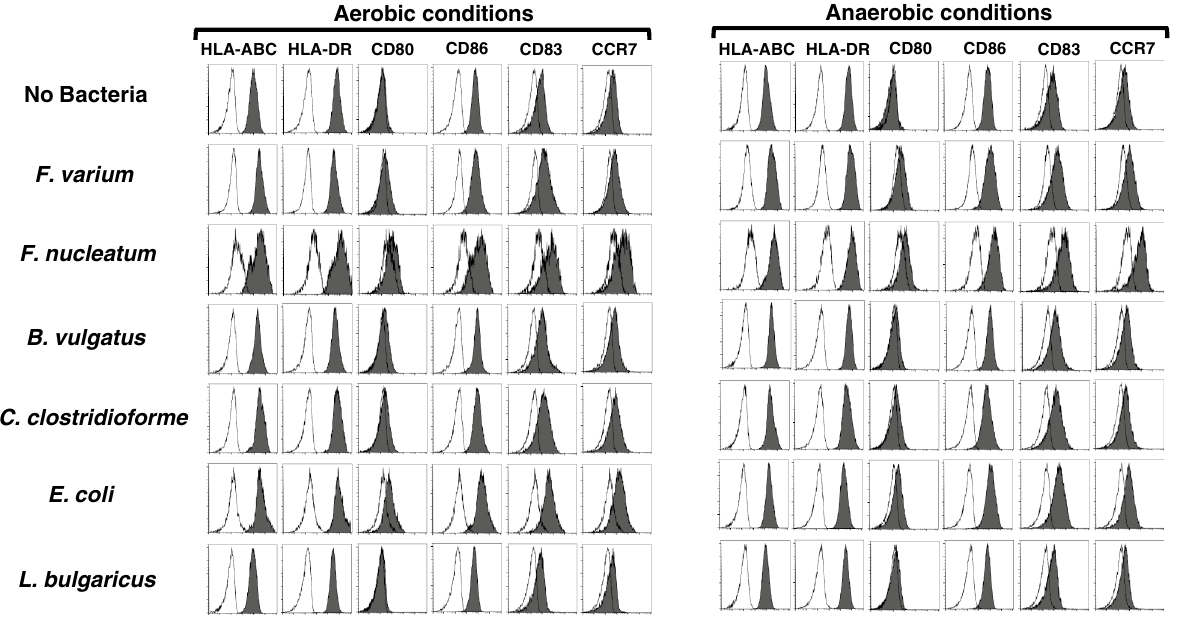
Figure 3. Phenotypic characterization of the DC line stimulated with live commensal bacteria under aerobic (left panel) or anaerobic (right panel) conditions for 4 h followed by an additional 20 h under aerobic culture conditions. Expression of the indicated antigens (black) or unstained controls (white) on the DC line was analyzed using flow cytometry. Similar results were obtained in three independent